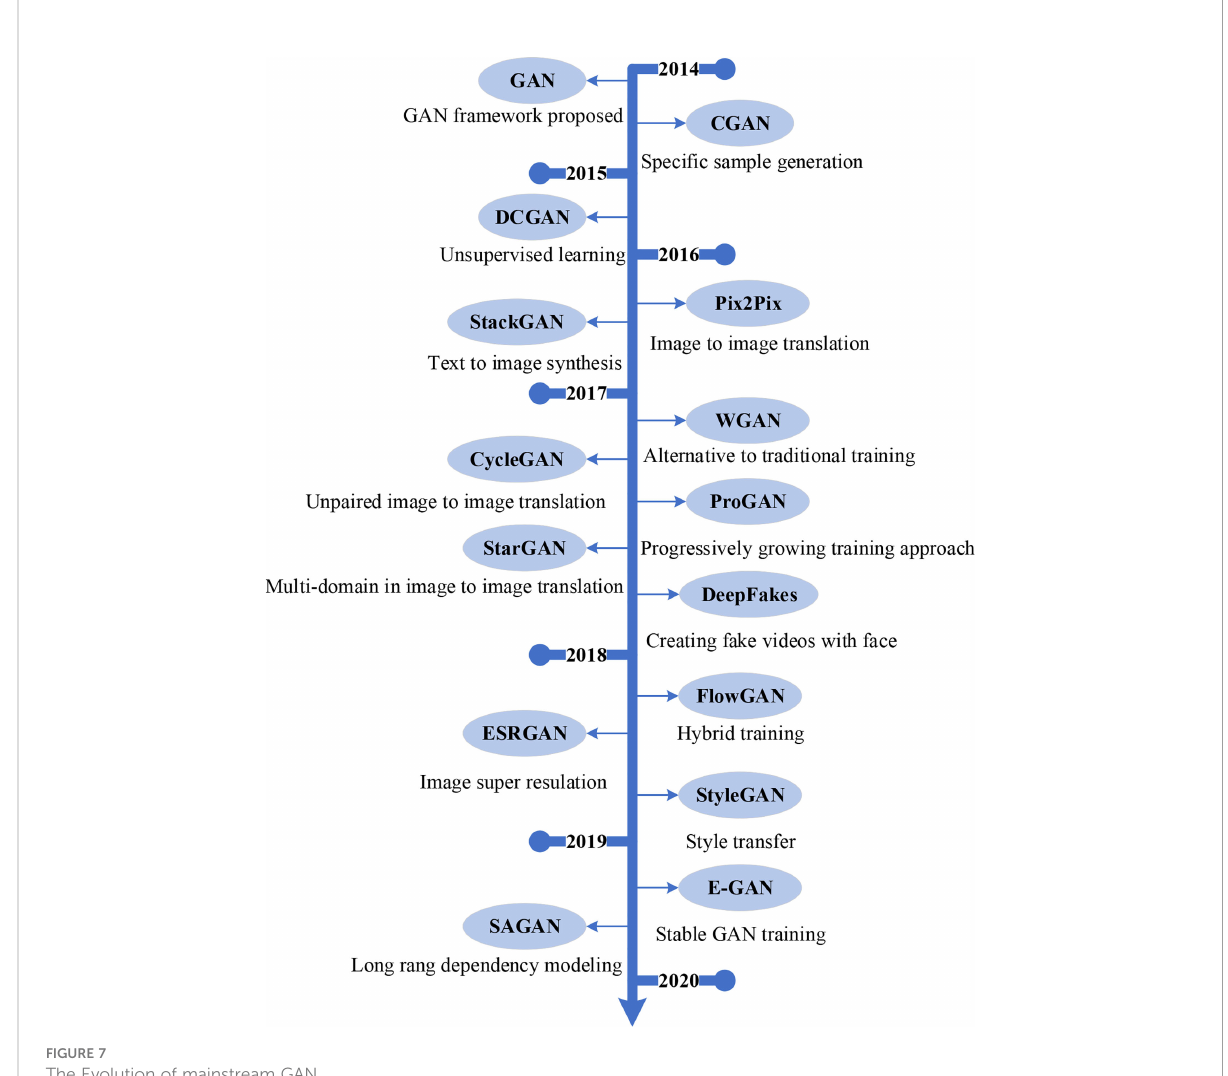
FIGURE 7 The Evolution of mainstream